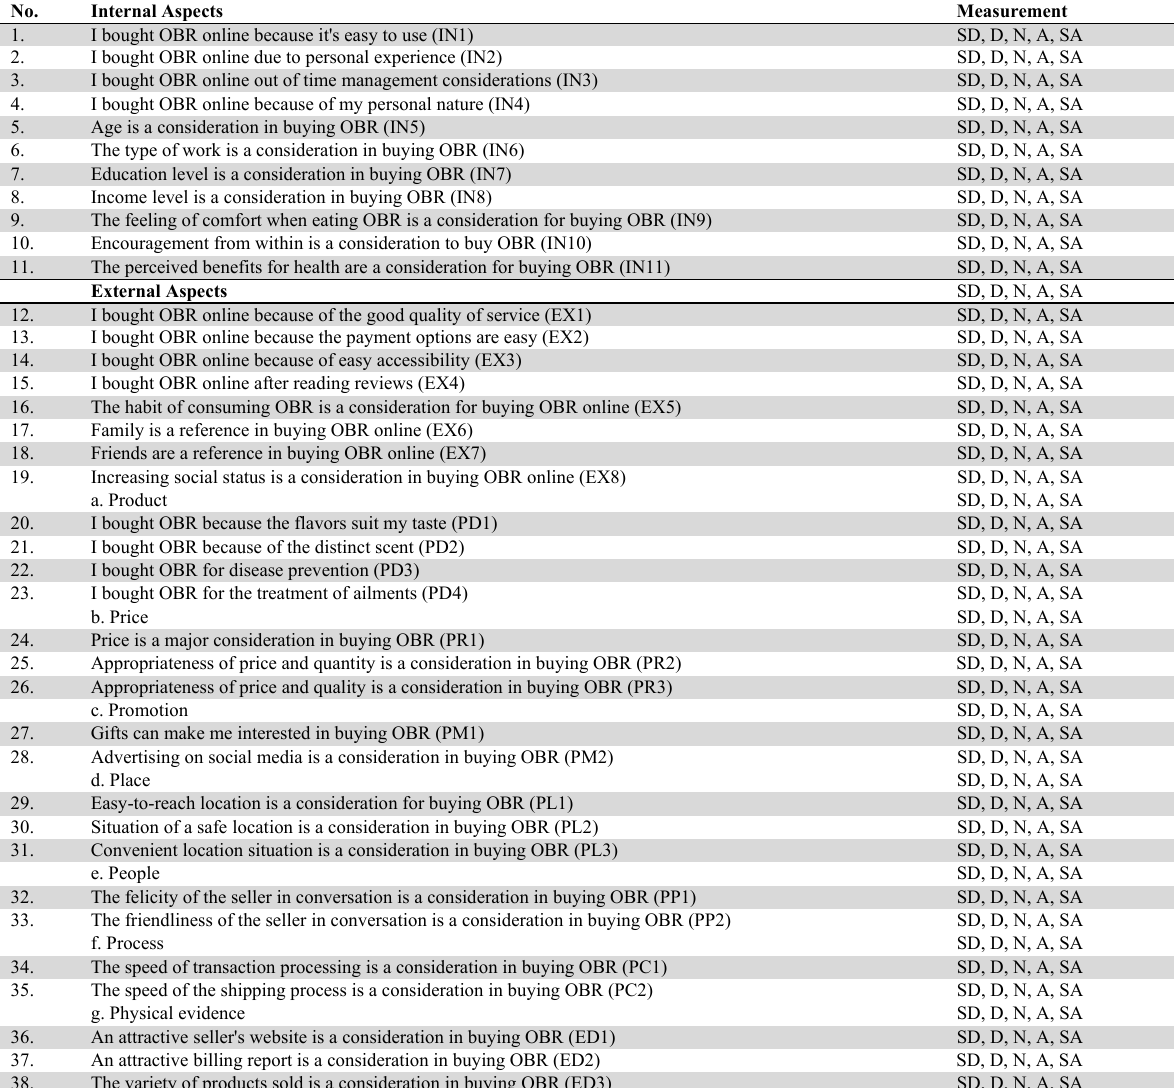
Variable and Measurement of Aspects that Influence OBR Online Purchase Decision via S-commerce No. Internal Aspects Measurement